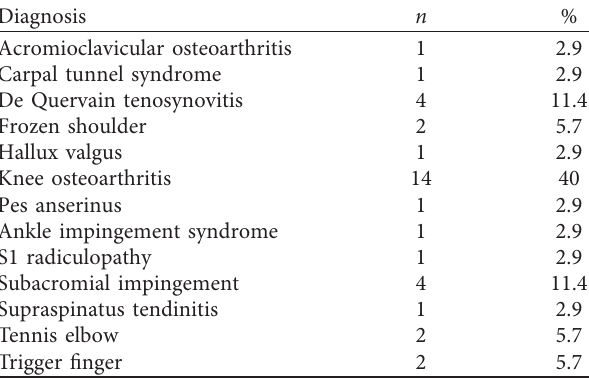
Table 3: Indications for musculoskeletal steroid